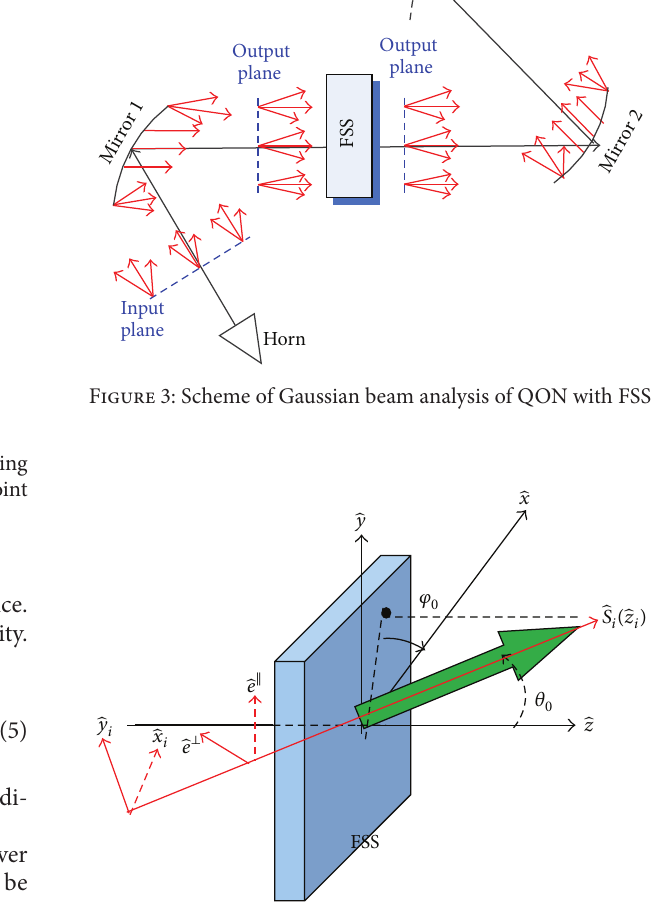
Figure 4: Illustration of single sub-GB passing through FSS struc-